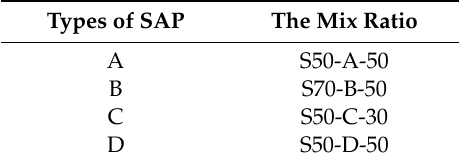
Table 11. The mix ratio of the four types of SAP water-retentive mortar.